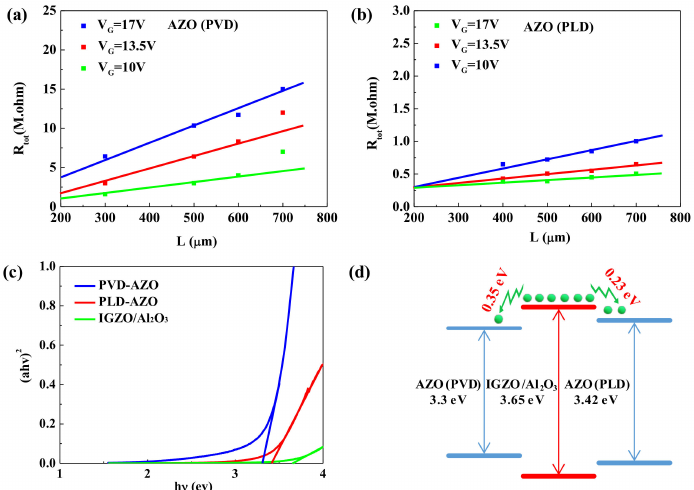
Figure 5. Total resistance as a function of the channel length at various V GS for ( a ) PVD-AZO-TFT and ( b ) PLD-AZO-TFT; ( c ) plot of ( α h ν ) 2 versus h ν for PVD-AZO, PLD-AZO, and IGZO/Al 2 O 3 multi-layer; ( d ) schematic of the electron transport between AZO films and the IGZO/Al 2 O 3 bi-layer.